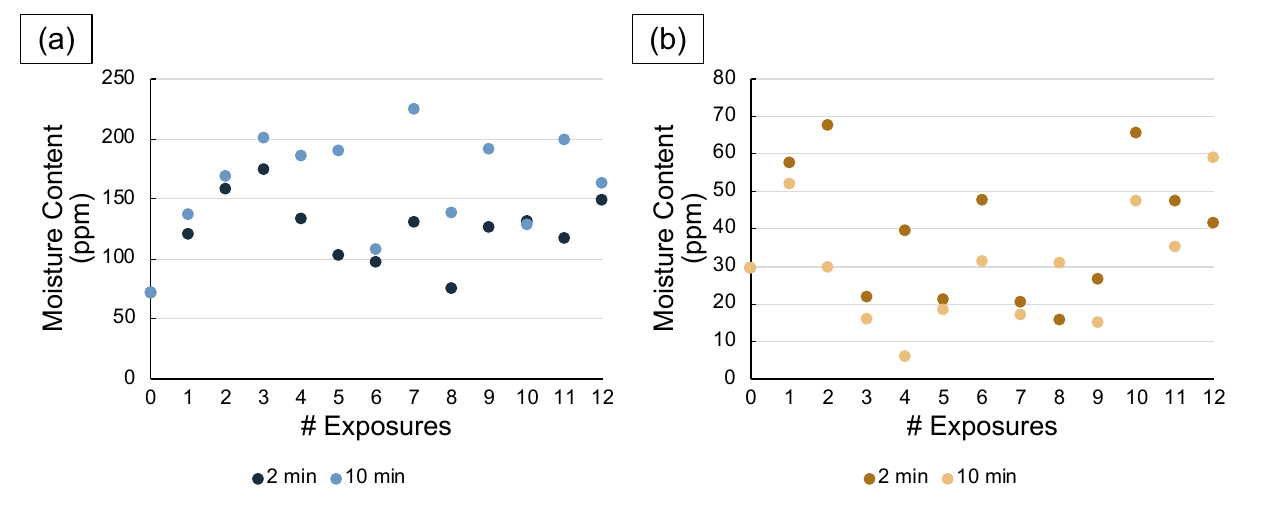
Figure 5. Moisture content (in ppm) of ( a ) the Al 5056 powder and ( b ) the Ta powder for Lots #0 through #12 (0 to 12 exposures) at both exposure durations (2 min and 10 min).